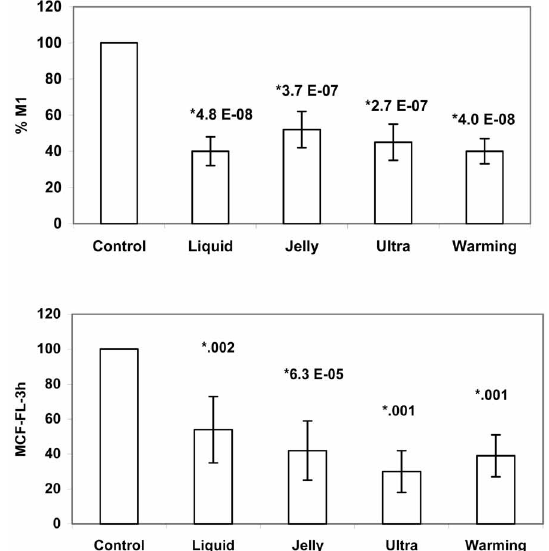
Figure 5. Effect of marketed intravaginal products on relative yeast cell hydrophobicity. Liquid formulations of K-Y 1 personal lubricant were used to suspend yeast before bead-binding assay. Standard K-Y 1 jelly was diluted 1:10 before suspending yeast, because of its much greater viscosity. Following a 30-minute exposure to the K-Y 1 products, yeasts were harvested by centrifugation at 10,000 rcf for 15 minutes, the supernatant was removed, the pelleted yeasts were resuspended in S-PBS and styrene microspheres were added. All formulations reduced bead binding, K-Y 1 ultra having the greatest effect. Asterisk indicates p 5 0.05.